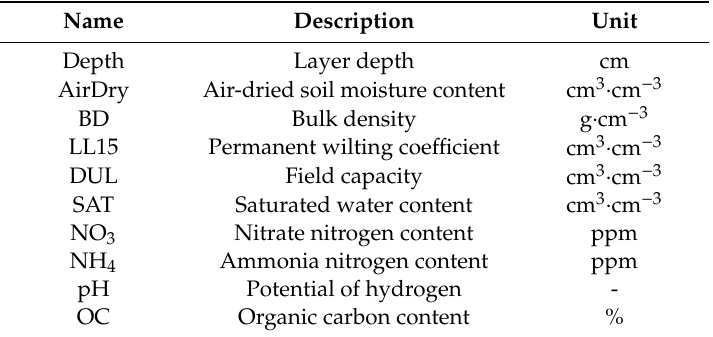
Table 5. Soil characteristic parameters of the APSIM sugarcane